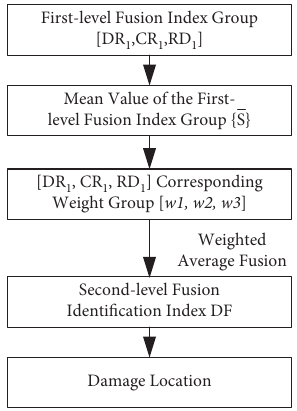
Figure 5: Second-level fusion method based on weighted average criterion.